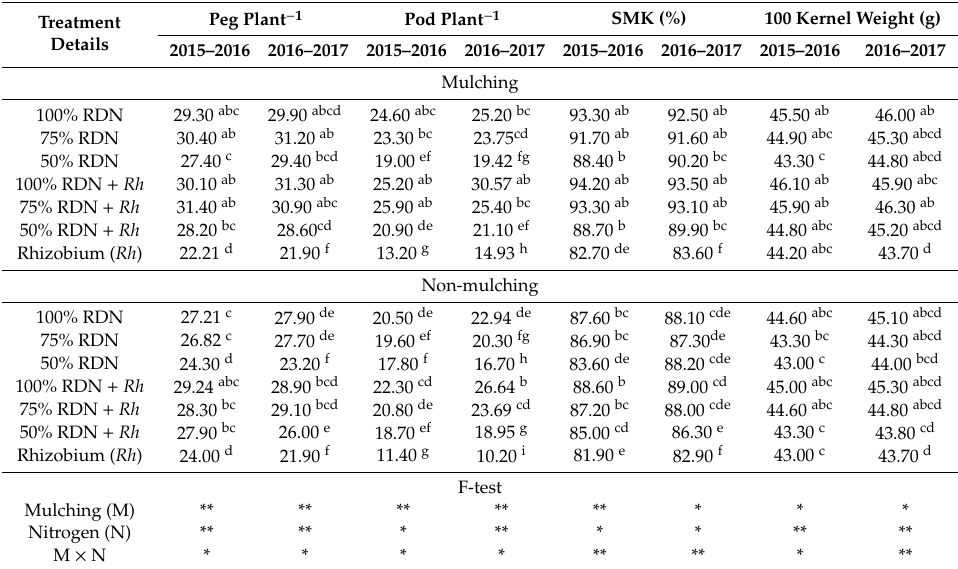
Table 2. Yield attributing traits of peanut under di ff erent mulching and nutrient management practices. Treatment